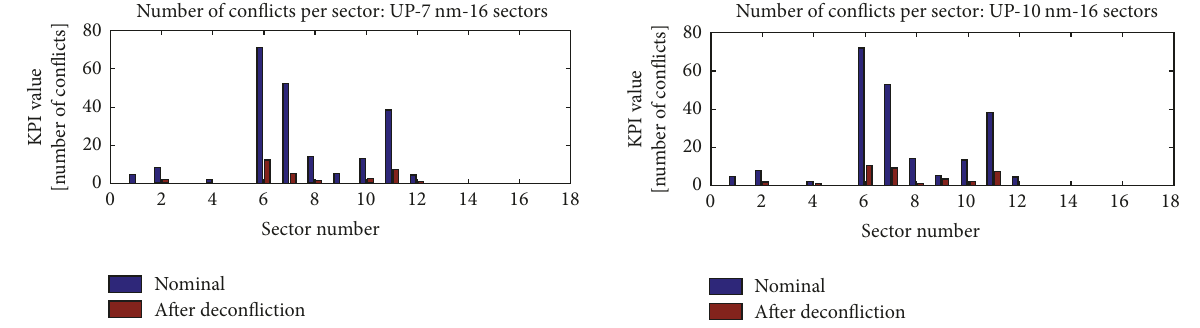
Figure 8: Number of conflicts per sector in the analysis cases of 7 NM/16 sectors and 10NM/16 sectors.